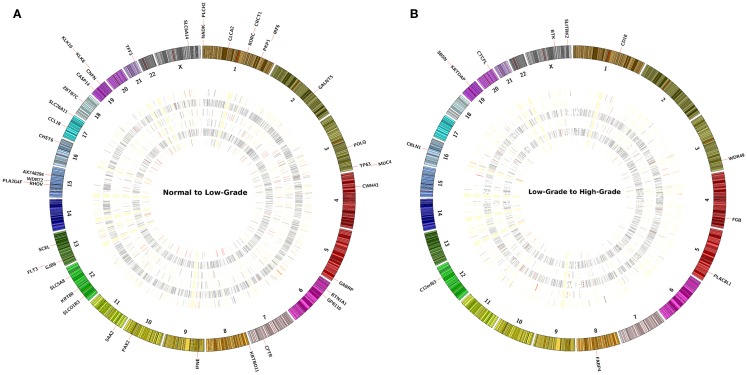
The concentric circles represent an heatmap of −log10(p-value) values of pairwise comparison of the sample’s FPKM (A) normal to LGSIL and (B) LGSIL to HGSIL in each of six samples. At the periphery of the heatmap are the genes that report a significant −log10(p-value) value across at least two samples or more. The concentric heatmaps are ordered from outmost to innermost in the following sample ID order: 109, 110, 111, 113, 115, and 116. Each band in the concentric circle represents a gene and its color scheme corresponds the −log(p-value); RED bands are values over 1.3, GRAY bands have range between 0.05 and 1.3 and WHITE (merging with the background of the plot) represents ≤0.05.